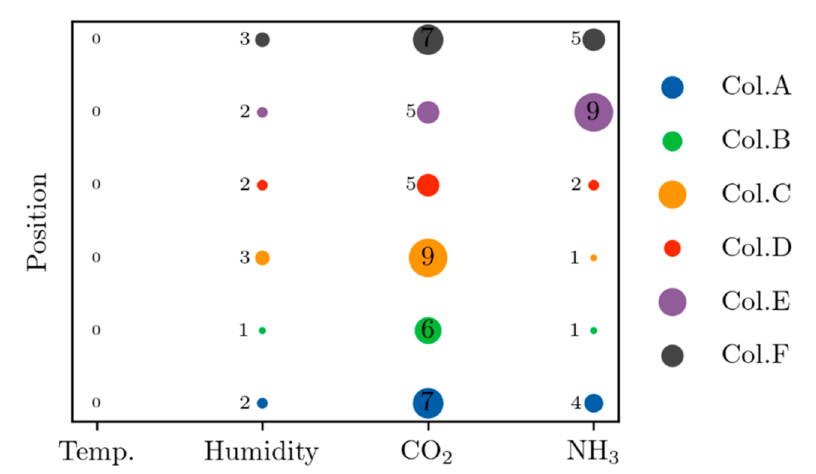
Figure 10. Percentage outlier rate comparisons on four environmental parameters recognized by the Turkey’s fences in six comparative mounting